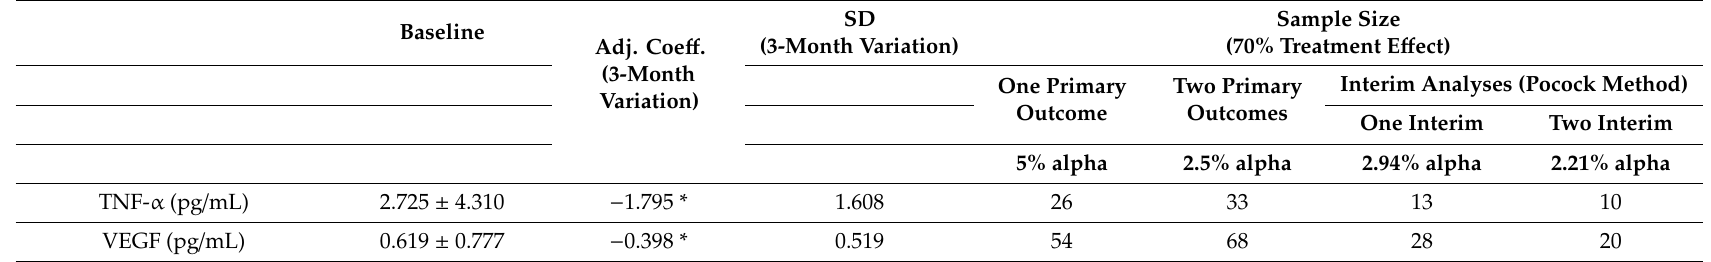
Table shows absolute values of biomarkers of oxidative stress and inflammation at the baseline visit. Adjusted beta-coe ffi cients (adj. coe ff .) of 3-month variation for each laboratory measure were obtained with mixed-e ff ect linear regression models (including age, gender, disease duration, baseline EDSS, and duration of Interferon- β 1a treatment prior to study inclusion as covariates; creatinine was also included for uric acid analyses) (* indicates p < 0.05). Standard deviation (SD) was calculated from the variation of each laboratory measure after 3 months. Sample size per treatment arm is reported, hypothesizing a 70% treatment e ff ect, compared with the observed e ff ect, over 3 months (power was set at 80%, alpha-error was set at 5%). Then, we also performed calculations hypothesizing additional scenarios: (i) two di ff erent biomarkers were included as combined primary outcome measures for sample size estimates (alpha-error was set at 2.5%); (ii) the study was designed to include one or two interim analyses in addition to the final analysis in order to obtain early evidence of inferior or useless treatment (alpha-error was set to be 0.0294 and 0.0221, respectively, according to the Pocock method). Abbreviations: intracellular ROS production (CellROX), mean fluorescence intensity (MFI), 8-hydroxy-2-deoxyguanosine (8-OHdG), epidermal growth factor (EGF), eotaxin, basic-fibroblast growth factor (FGF), granulocyte-colony stimulating factor